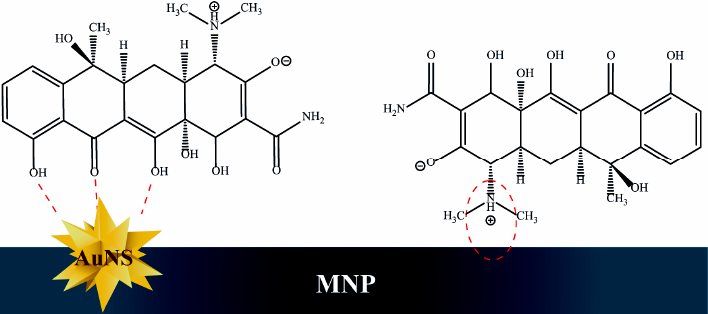
Figure 8. Schematic illustration showing TC molecules interacting with the hybrid nanostructures composed of AuNS and Fe 3 O 4 particles.